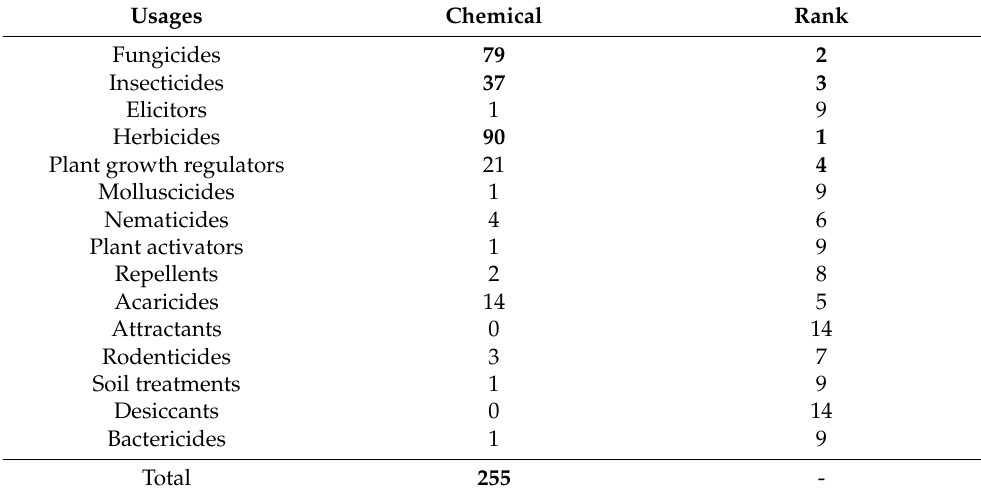
Table 1. Functions of the chemicals. Usages Chemical Rank Fungicides 79 2 Insecticides 37 3 Elicitors 1 9 Herbicides 90 1 Plant growth regulators 21 4 Molluscicides 1 Nematicides Plant activators Repellents Acaricides Attractants 0 Rodenticides Soil treatments Desiccants 0